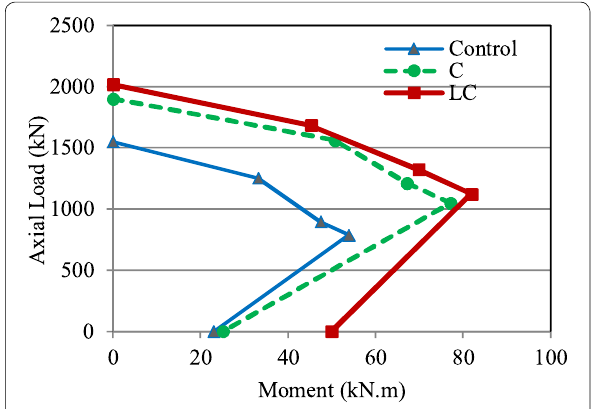
Fig. 7 Experimental P – M interaction